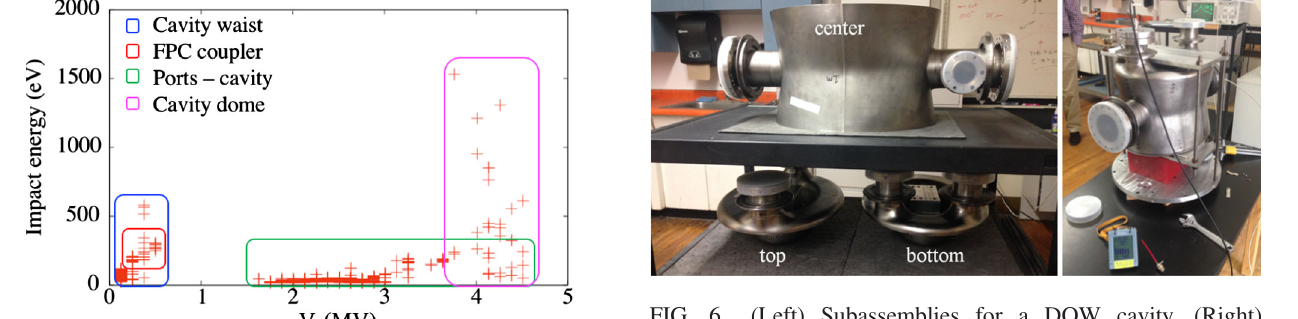
FIG. 6. (Left) Subassemblies for a DQW cavity. (Right) Clamped assembly of a DQW